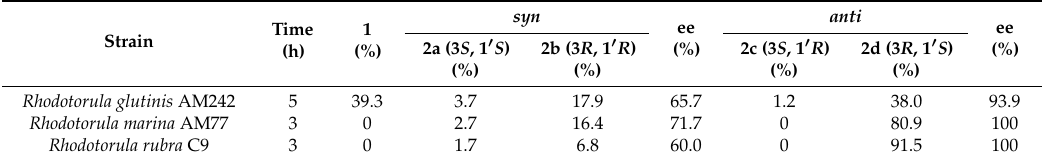
Table 4. The results of biotransformation of α -acetylbutyrolactone 1 (in % according to GC (chiral column)).